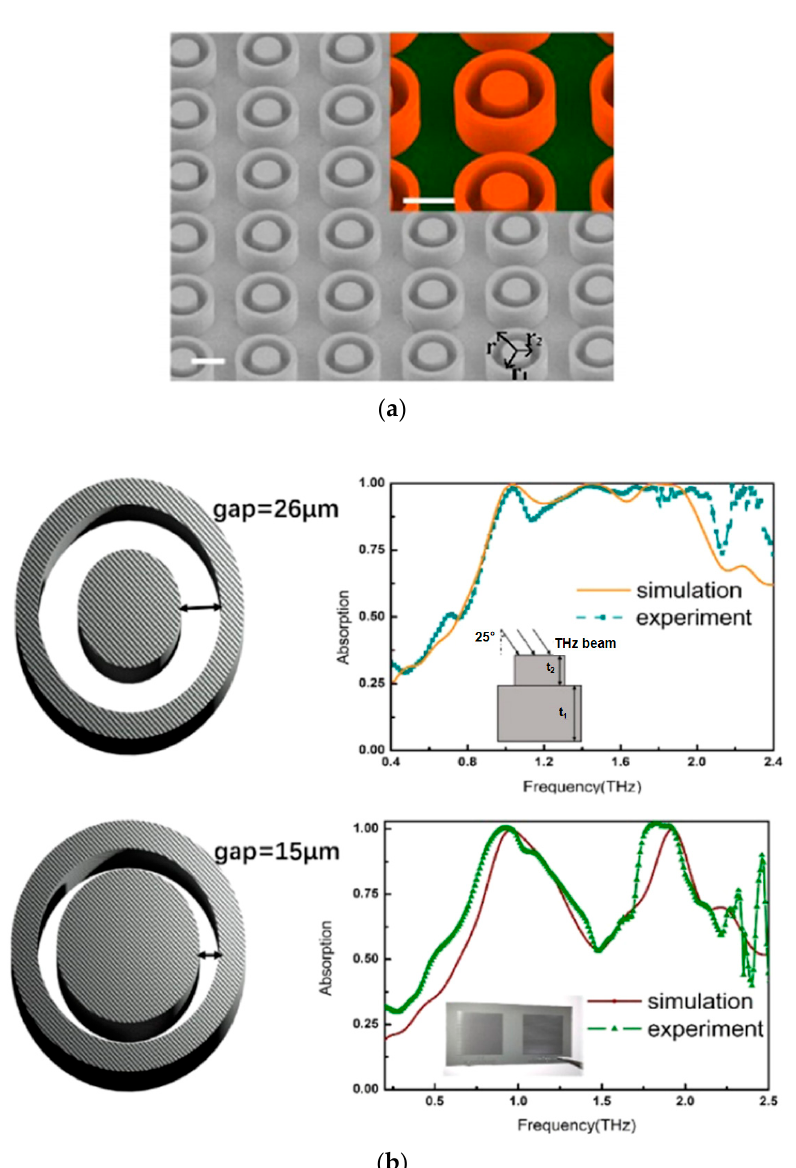
Figure 13. ( a ) SEM image of the designed PMAs; ( b ) illustrations of unit cells of SRRs and simulated (yellow curve) and measured (green curve) absorption characteristics of the broadband PMAs [51].